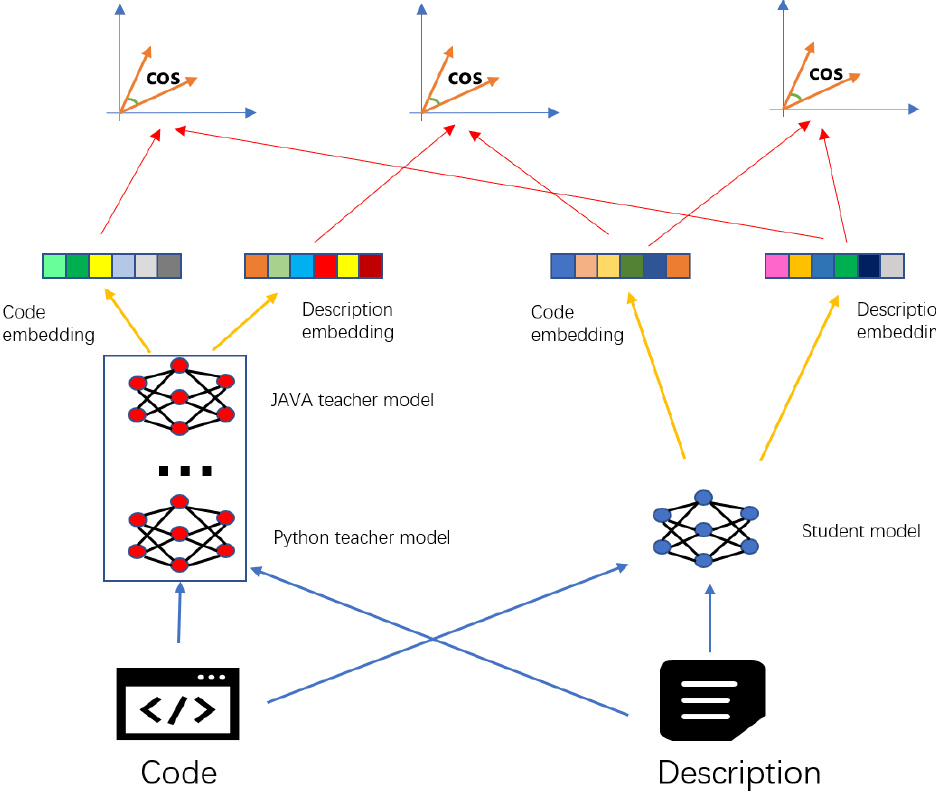
Figure 3. Schematic diagram of the overall